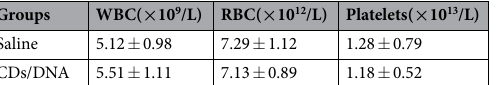
Table 2. Mice blood cell counts after intravenous treatment with CDs/DNA for 7days, ones dose per day (n =